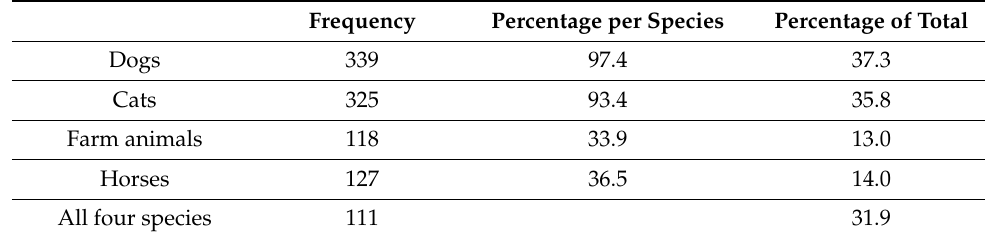
Table A6. Animal intubations performed.